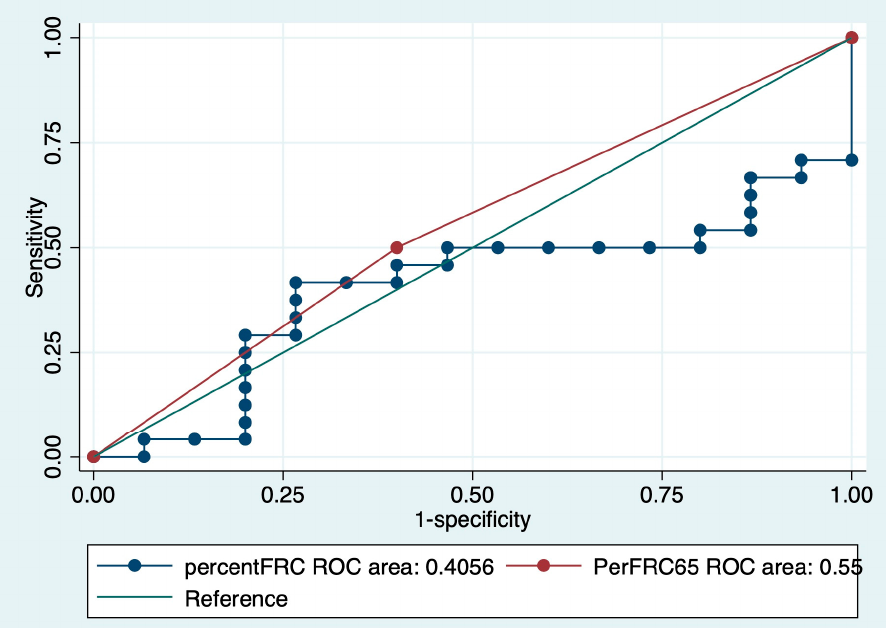
Figure 5. ROC curve of %FRC for IPF mortality.